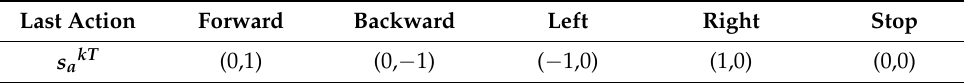
Table 1. The correspondence between the last action and s akT. Last Action Forward Backward Left Right Stop s akT (0,1) (0, − 1) ( − 1,0) (1,0)